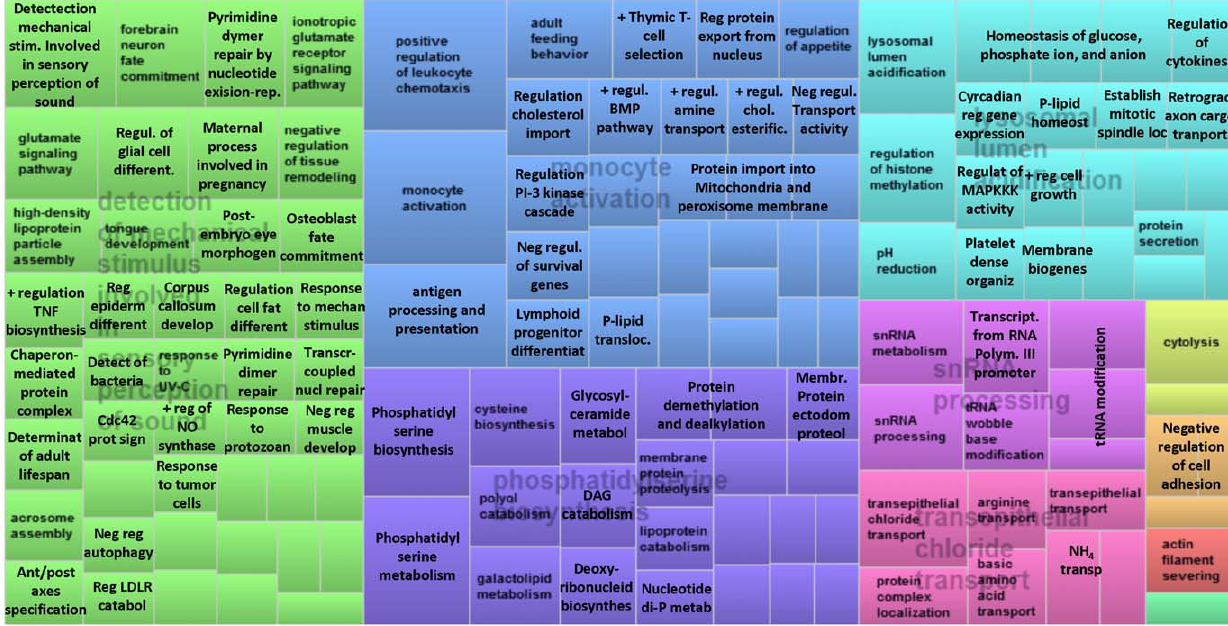
Figure 4. TreeMap visualization obtained by REVIGO analysis (see Materials and Methods for details) of the summary of GO Biological process deemed by DIA to be overall inhibited during full lactation (from 15 to 120 d) compared to 2 30 d. Similar colors denote semantic similarity and dimension of the area is proportional to the overall direction of the impact, as calculated by the DIA. Not all the terms are reported due to space constraints (see Additional file S4 for details).